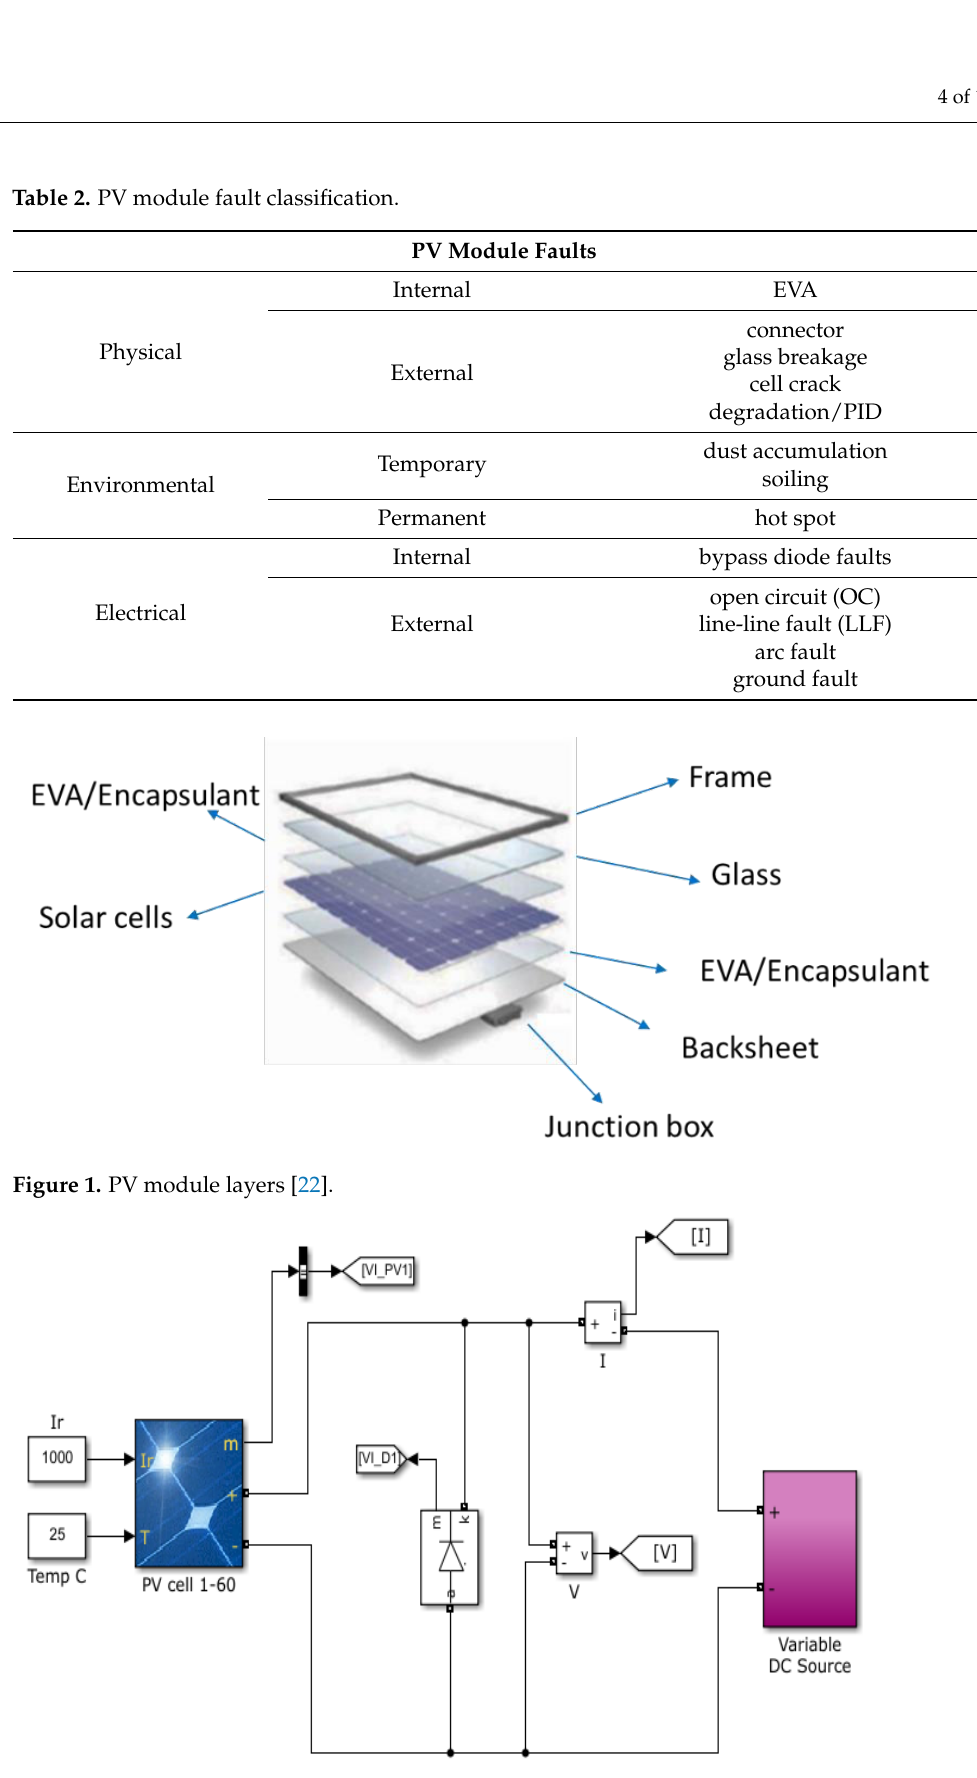
Figure 2. PV system simulation.